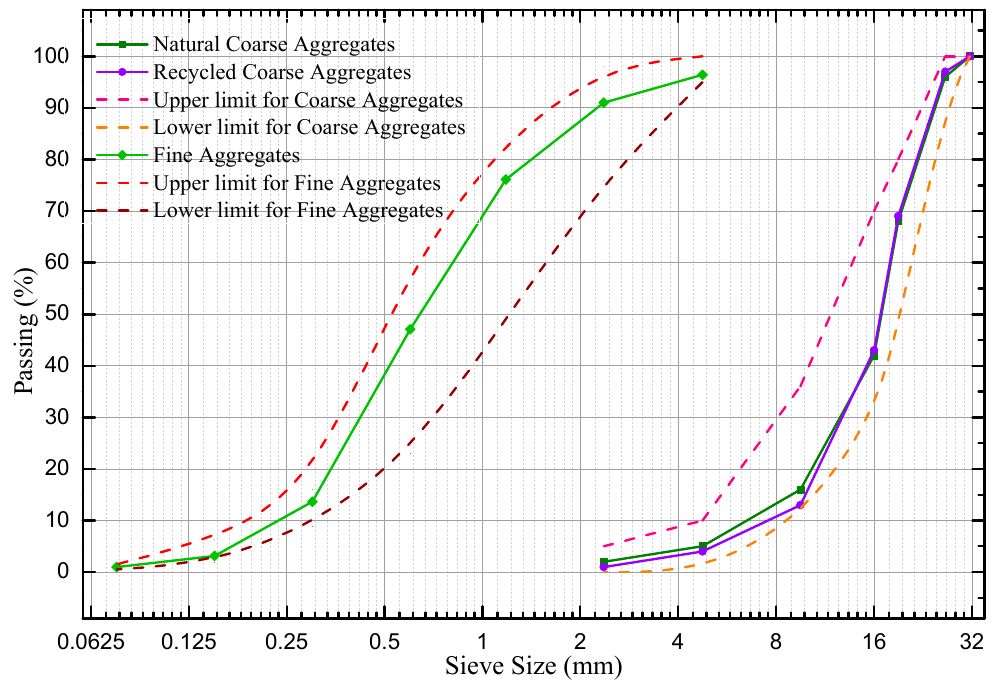
Figure 2. Aggregates gradating curves.